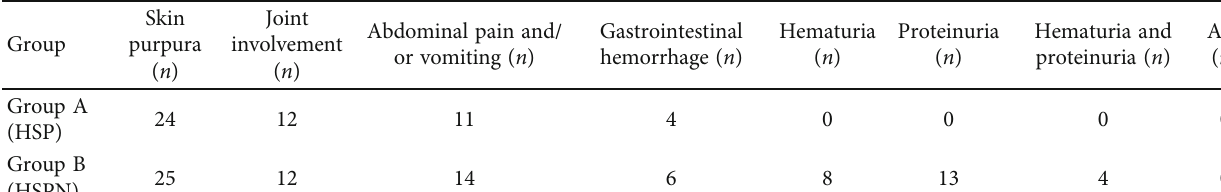
Table 1: Clinical manifestations of HSP and HSPN.